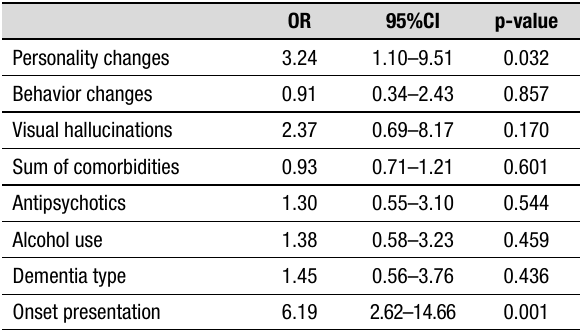
Table 2. Multivariable-adjusted predictors of time to the symptom onset to specialist